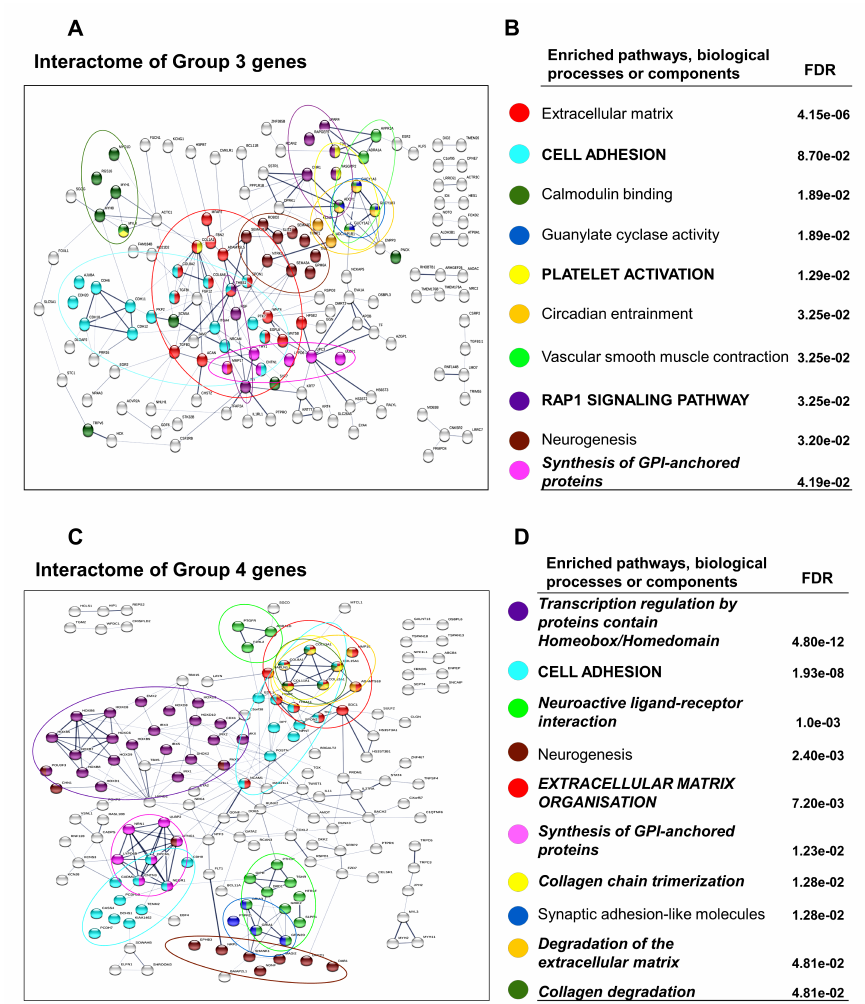
Figure 4. Interactome maps and enriched pathways, biological processes, or cellular components expressed lower in deep-neck (DN) as compared to subcutaneous (SC) adipocytes. Groups of genes were defined in Figure 3A. ( A ) Interactome map and ( B ) Selected Significantly Enriched pathways and their false discovery rate (FDR) values based on DN vs. SC di ff erentially expressed genes in Group 3; interaction score confidence value: 0.4. ( C ) Interactome map and ( D ) Selected significantly Enriched pathways and their FDR values in Group 4; interaction score confidence value: 0.4. Edges represent protein-protein based interactions. Italic font: pathway also appears in preadipocyte state; Capital letters: Pathway also appears in FTO obesity-risk allele-based